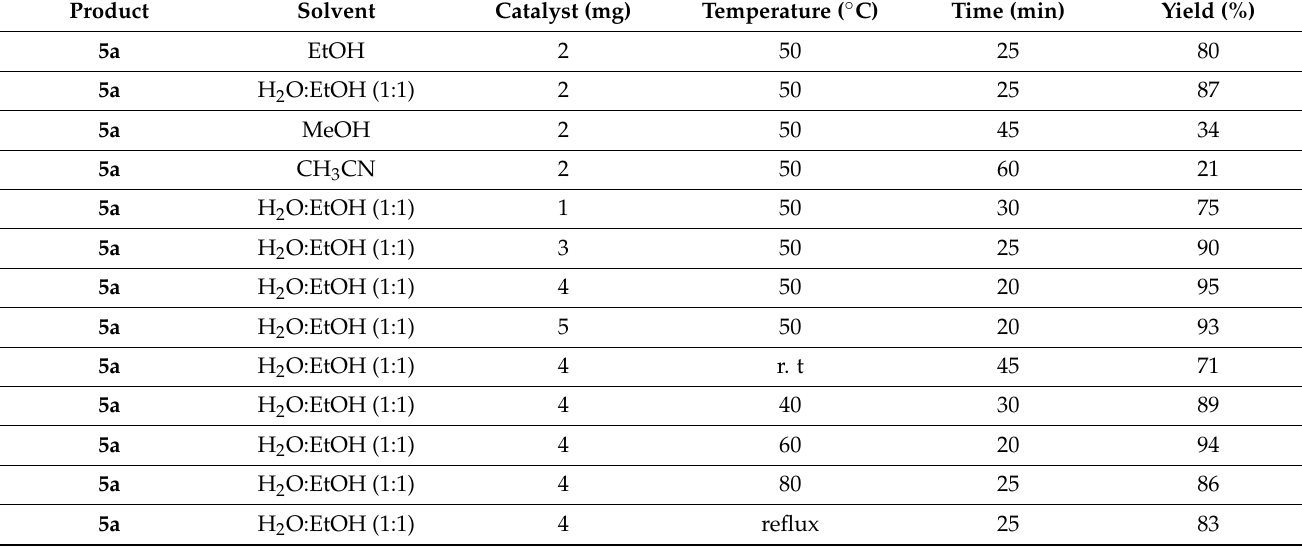
Table 1. Optimization of solvent, amount of catalyst, and temperature in the